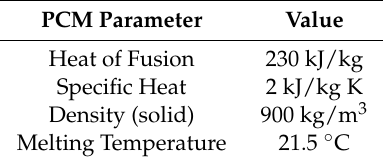
Table 6. PCM Table 6. PCM Parameters.